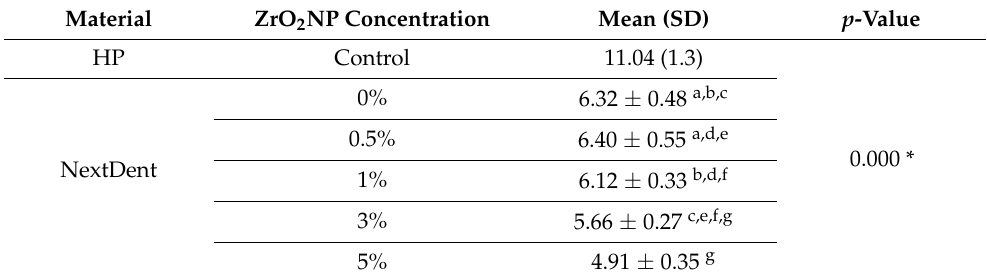
Table 3. Translucency mean values, SD, and significance between HP and NextDent test groups. Table 4. Translucency mean values, SD, and significance between HP and ASIGA tested